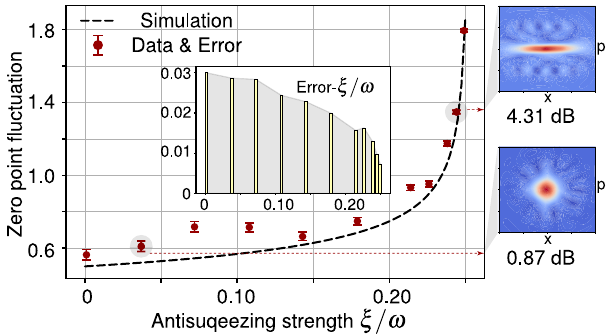
Fig. 2 Experimental measured ZPF (red circles) versus the antisqueezing strength ξ , demonstrating exponentially enhanced ZPF of the oscillator by the antisqueezing effect. The theoretical expectation is shown in the dashed line. The inset plot shows the standard deviation of ZPF for each data point. The measured Wigner functions of two squeezed vacuum states are shown in the right